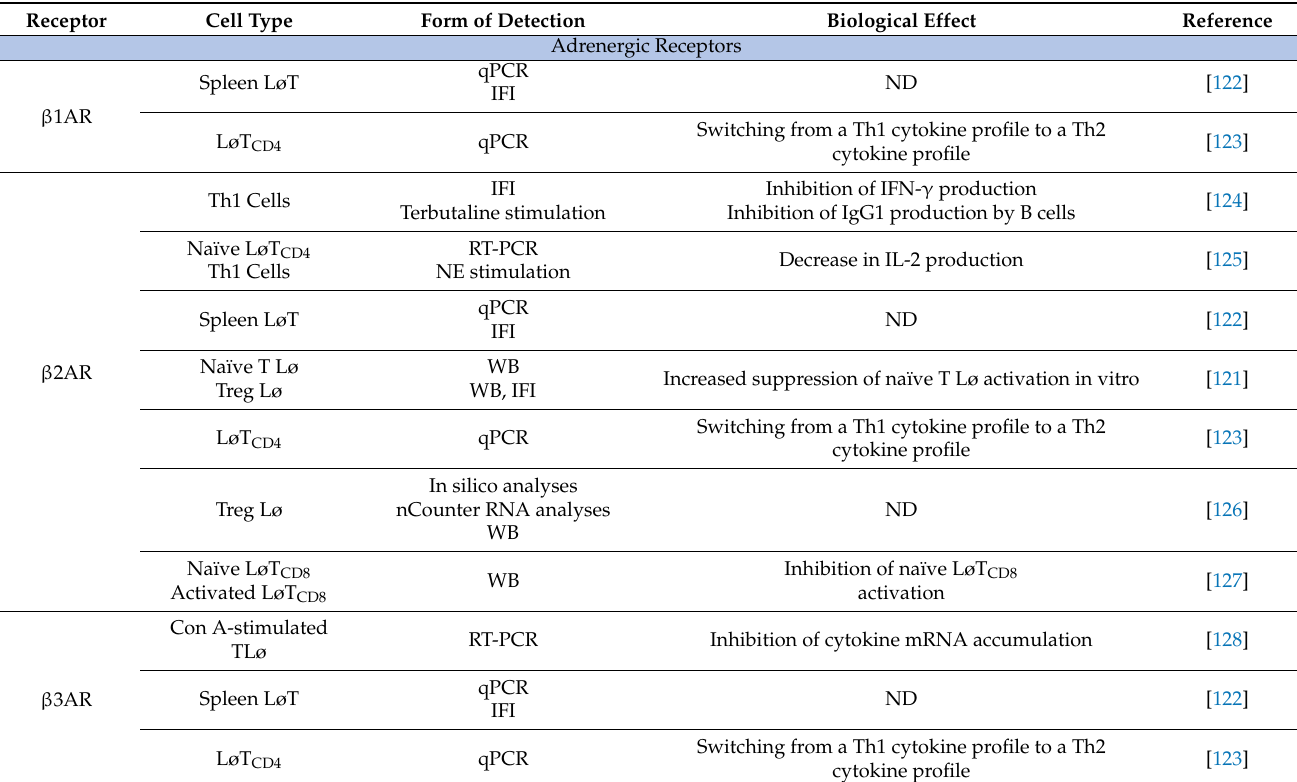
Table 3. Expression of adrenergic and cholinergic receptors in primary T lymphocytes. Only studies using primary cells that positively identified the expression of neurotransmitter receptors in T lymphocytes were